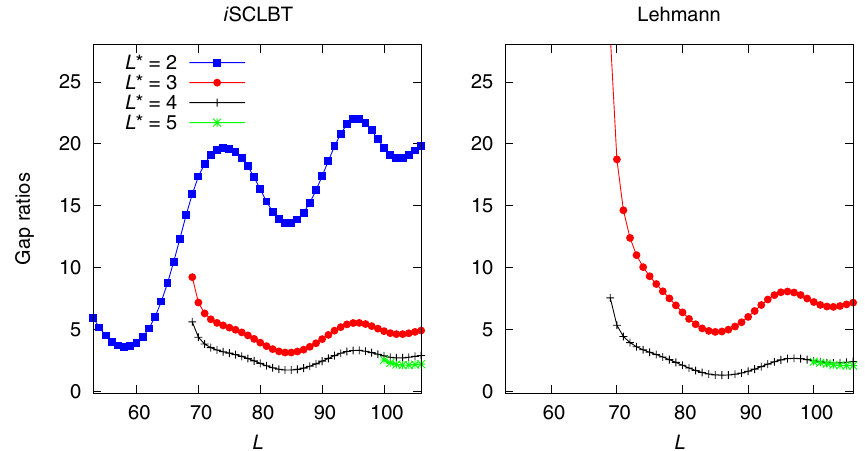
Figure 4. Comparison of first excited state lower bound gap ratios calculated by the i SCLBT and Lehmann methods for the Hubbard model. The blue line indicates i SCLBT calculation at L ∗ = 2 and the red, gray, and green lines indicate results at L ∗ = 3 , L ∗ = 4 , and L ∗ = 5 , respectively, for both methods.